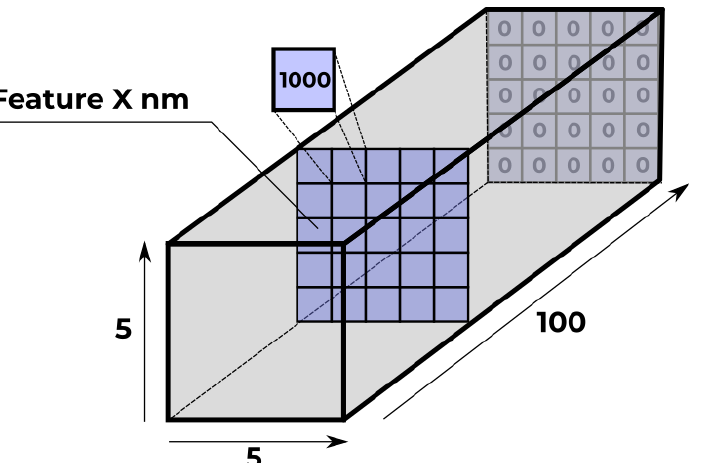
Figure A1. The main idea of key wavelengths discrimination.